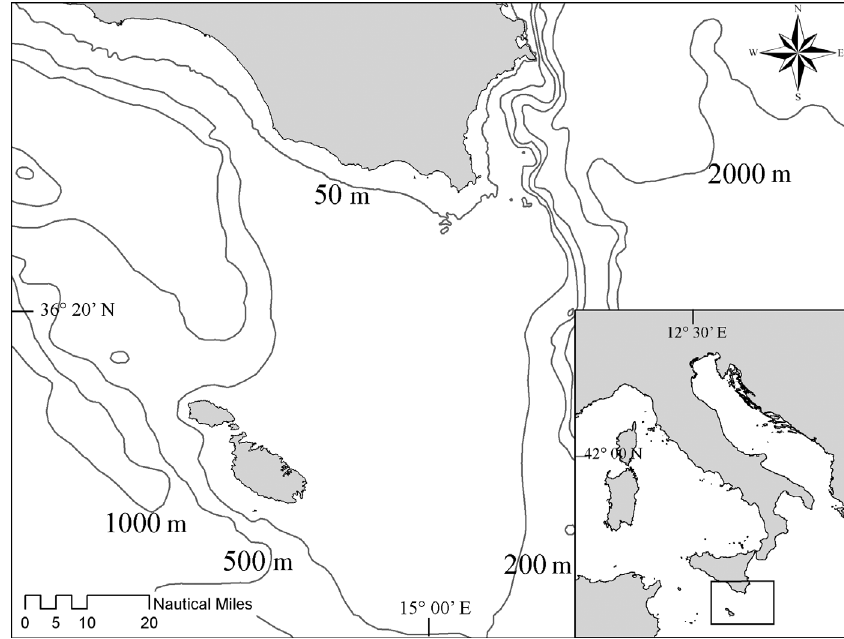
Fig . 1. – Geographic location of the shark sampling area.